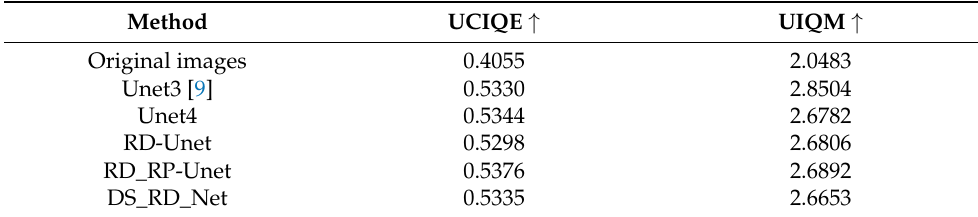
Table 2. Evaluation results of non-reference indicators on real underwater